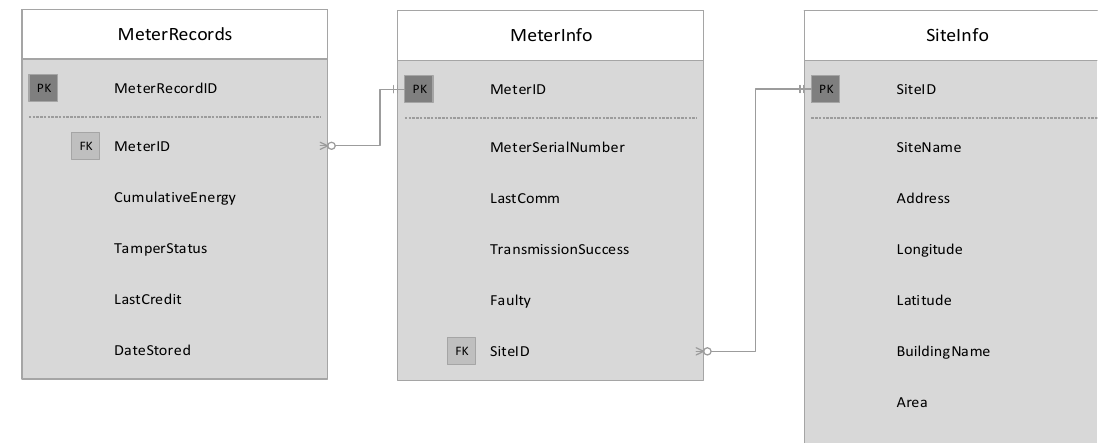
Figure 6. Data Collector Database Design.